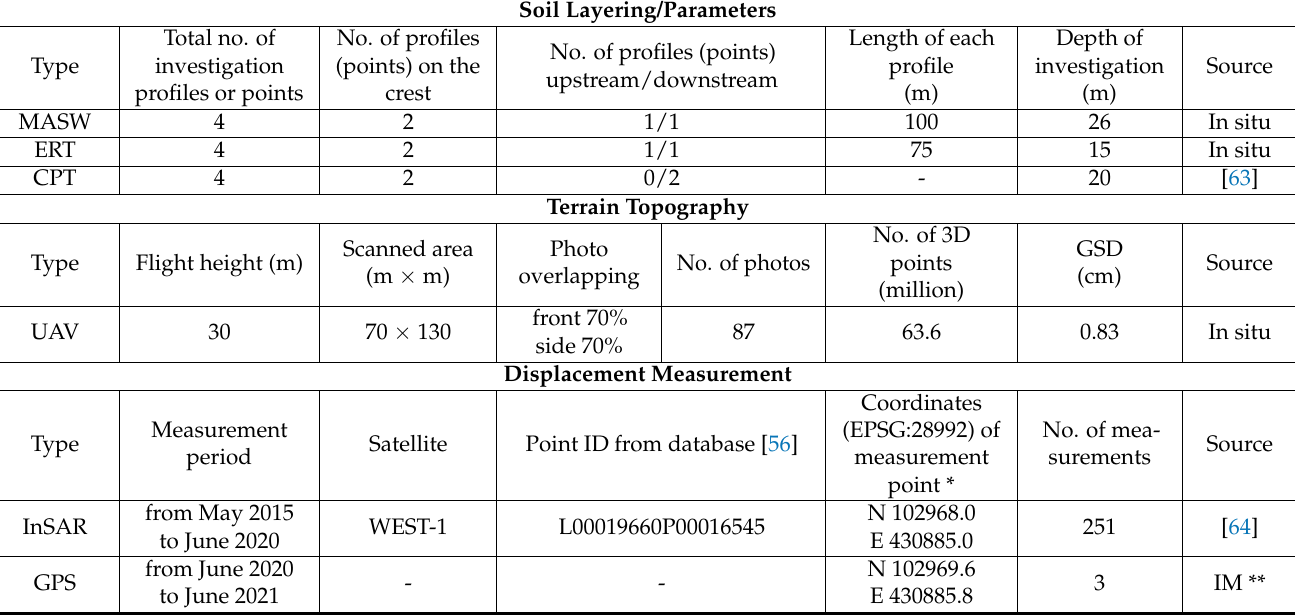
Table 1. Overview of the Oostmolendijk investigation methods and displacement monitoring. Soil